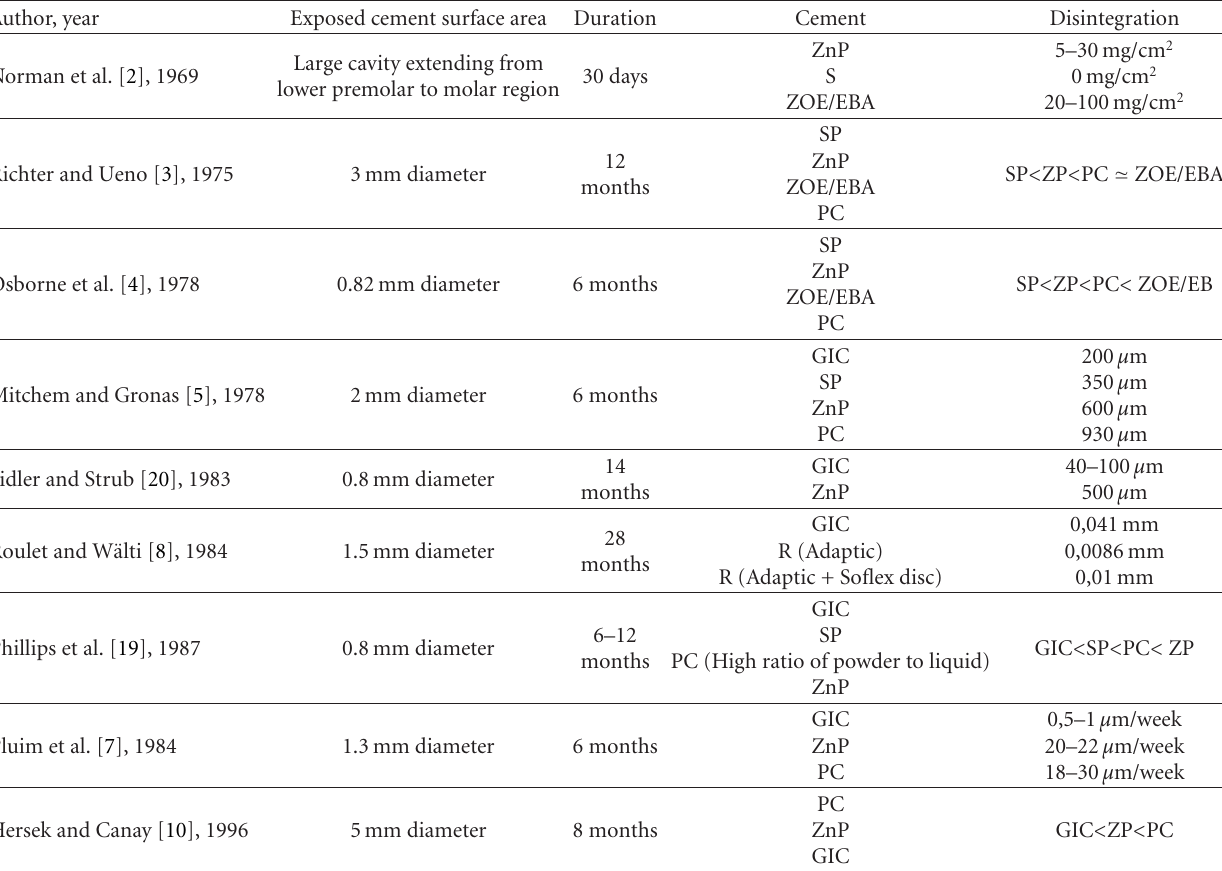
Table 1: In vivo disintegration studies on luting cements.